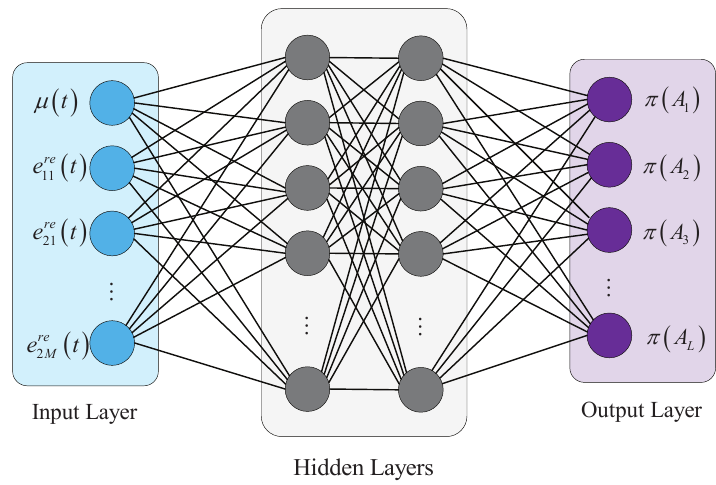
Figure 7. The deep neural network in the